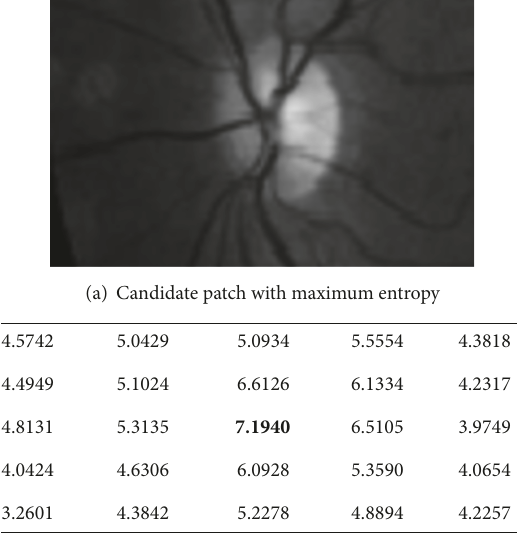
Figure 6: New region ( 𝑅